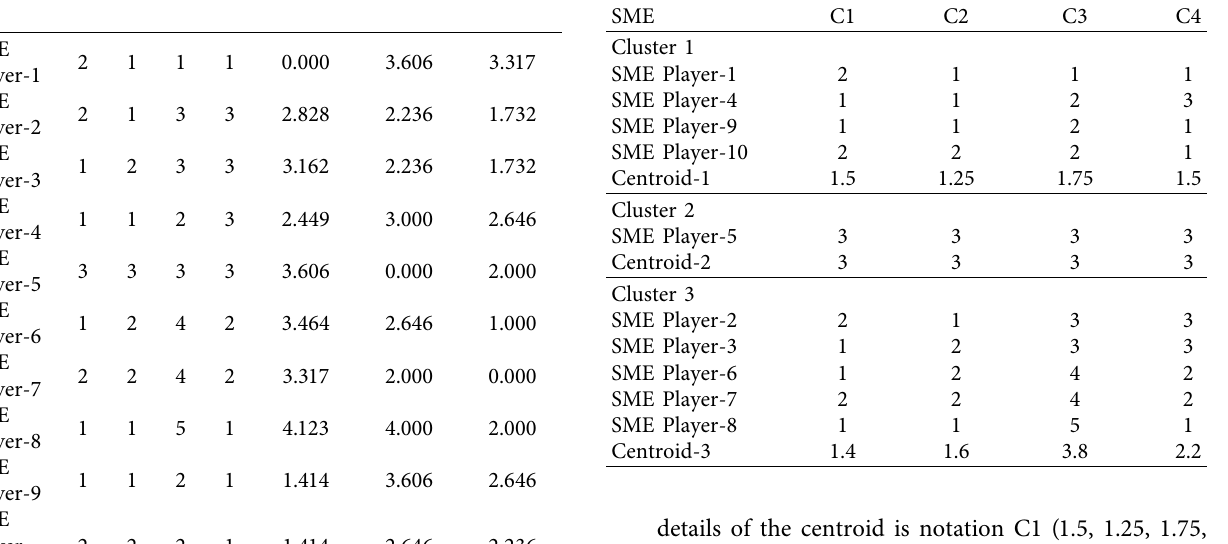
Table 16: Euclidean distance in the first iteration. SME player